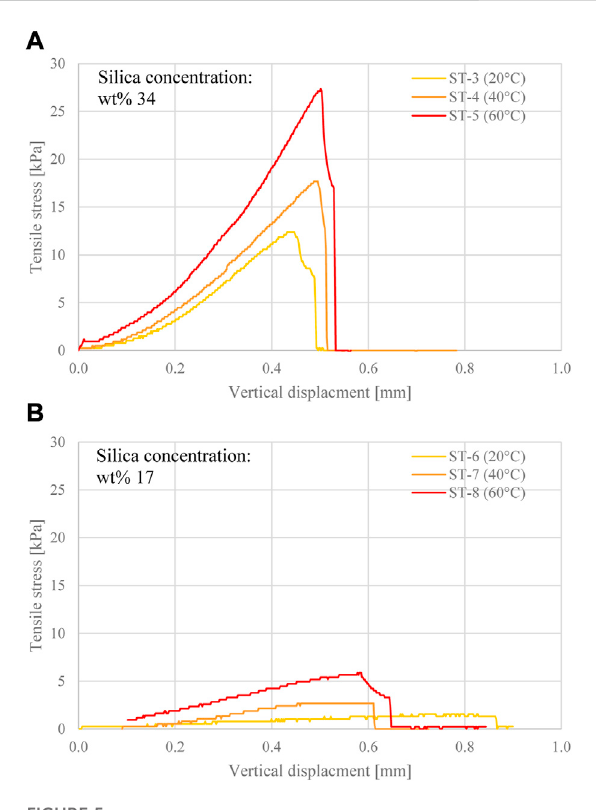
FIGURE 5 Tensile stress evolution with vertical displacement for